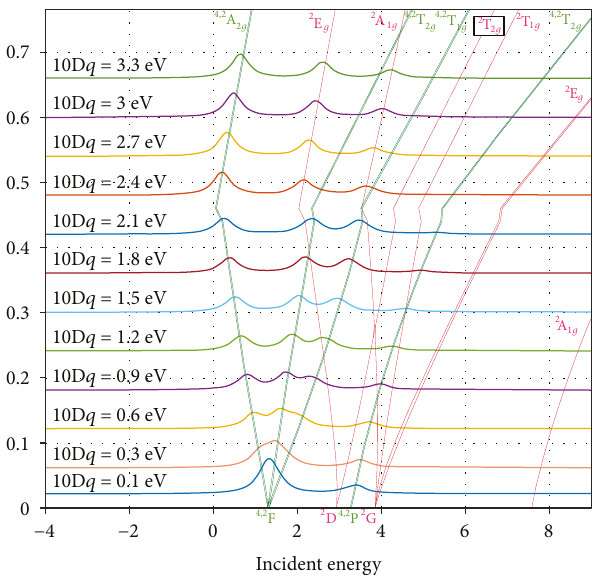
Figure 53: 1s XAS projections of a calculated 1s2p RIXS spectrum for Co 2+ ( 3d 7 ) with ELD. It con fi rms that in high spin only the quartet terms 4,2 F and 4,2 P contribute to the 1s XAS. The high spin to low spin transition appears at approximately 10D q ≈ 2 2 eV